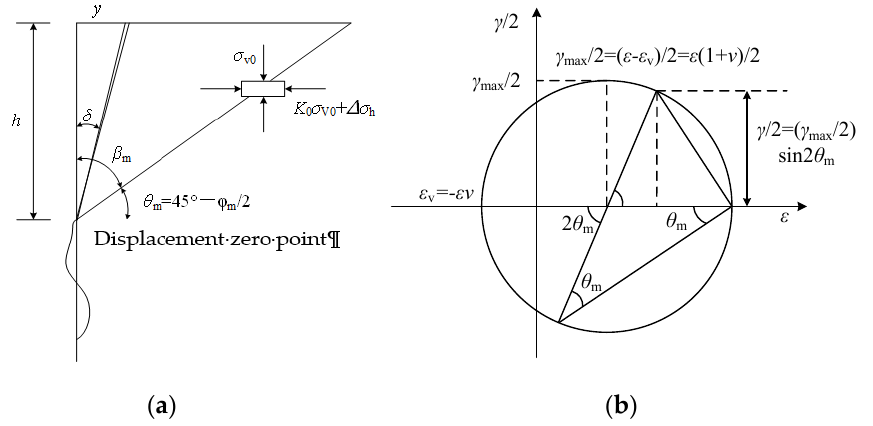
Figure 4. Displacement‒strain relationship: ( a ) horizontal deformation mode; ( b ) Mohr circle of strain.